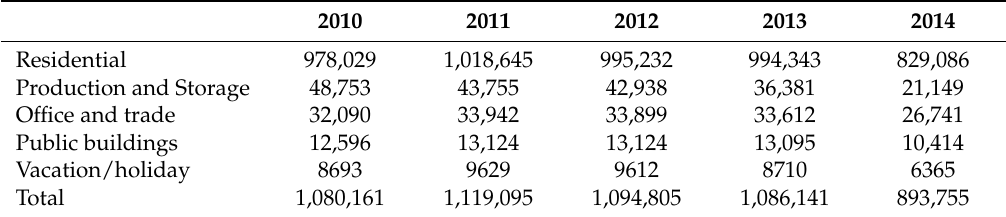
Table 2. Frequency of measurements categorised by building type and